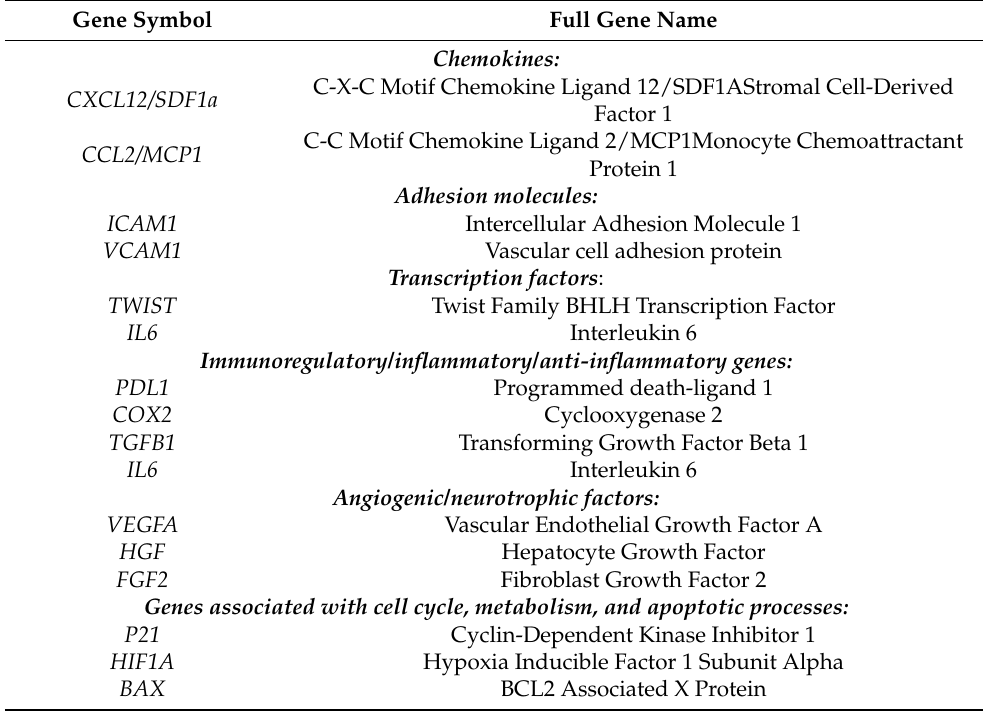
Table 1. Evaluated genes and